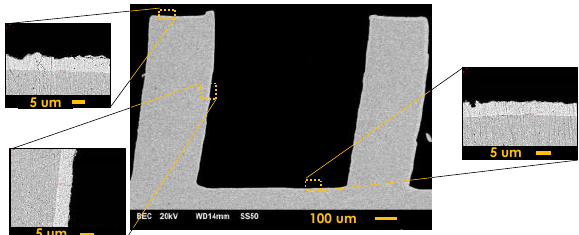
Fig. 2. SEM images of nickel-plated stainless steel corrugations. The images show the uniformity of the plating process. The slight distortion of the corrugations occurred when the sample was cut.